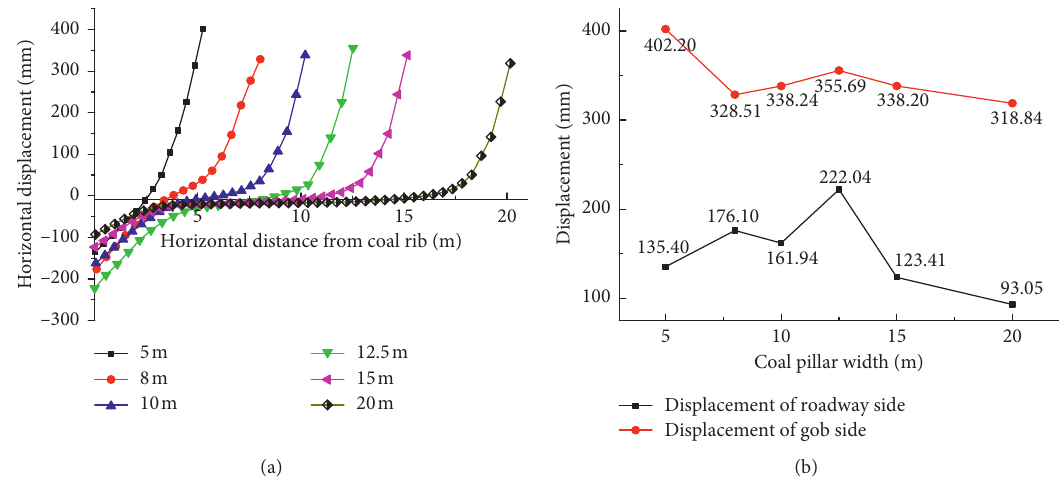
Figure 9: Horizontal displacement distribution curves under coal column of different widths. (a) Coal pillar midline displacement curve. (b) Maximum displacement value on both sides of the coal